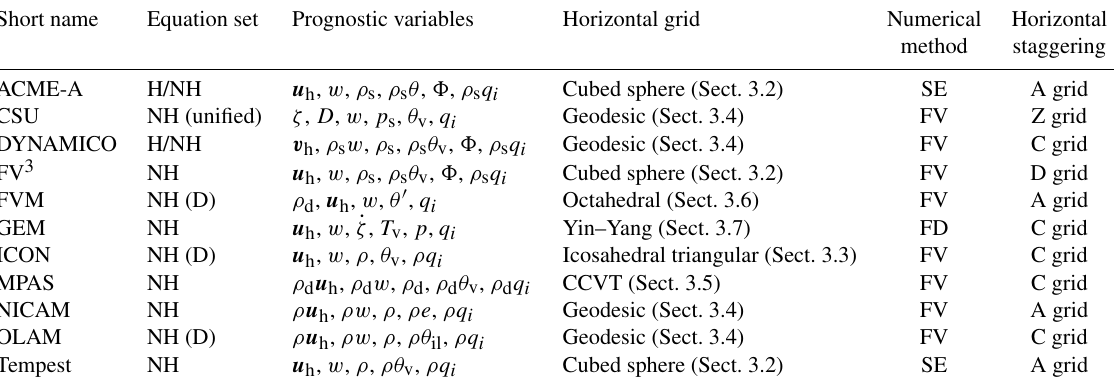
Table 3. Details on the prognostic variables and horizontal discretization for participating dynamical cores. The equation set indicates whether a model is hydrostatic (H) or non-hydrostatic (NH), and whether the model presently supports the deep-atmosphere formulation (D). Only three numerical methods are represented among participating models, namely finite difference (FD), finite volume (FV), and spectral element (SE). More details on horizontal staggering can be found in Sect.